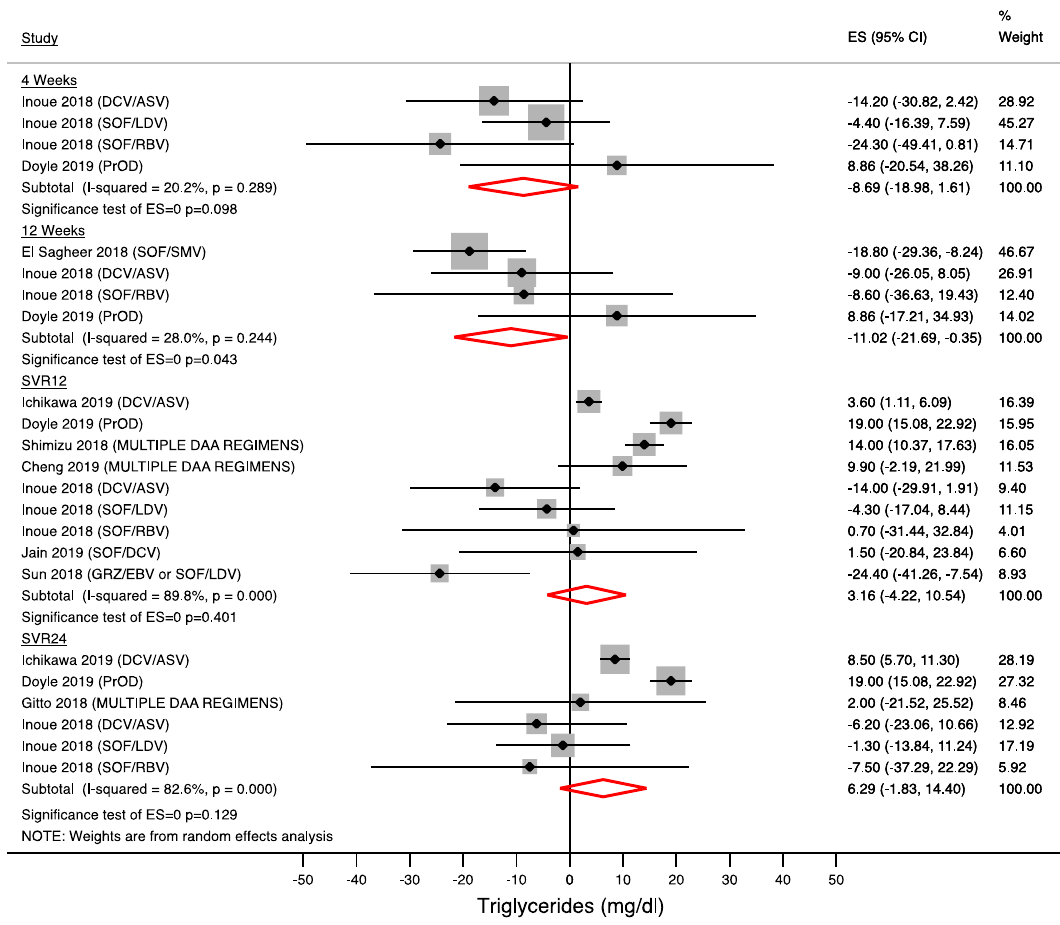
Figure 7. Serum Triglycerides changes during and after treatment. Forest plot for mean difference (MD) and 95% confidence intervals (CI) for each time-point. DCV/ASV daclatasvir/asunaprevir, SOF/LDV sofosbuvir/ ledipasvir, PrOD paritaprevir/ritonavir/ombitasvir + dasabuvir, SOF/DCV sofosbuvir + daclatasvir, SVR12 Sustained virological response at 12 weeks, SVR24 Sustained virological response at 24